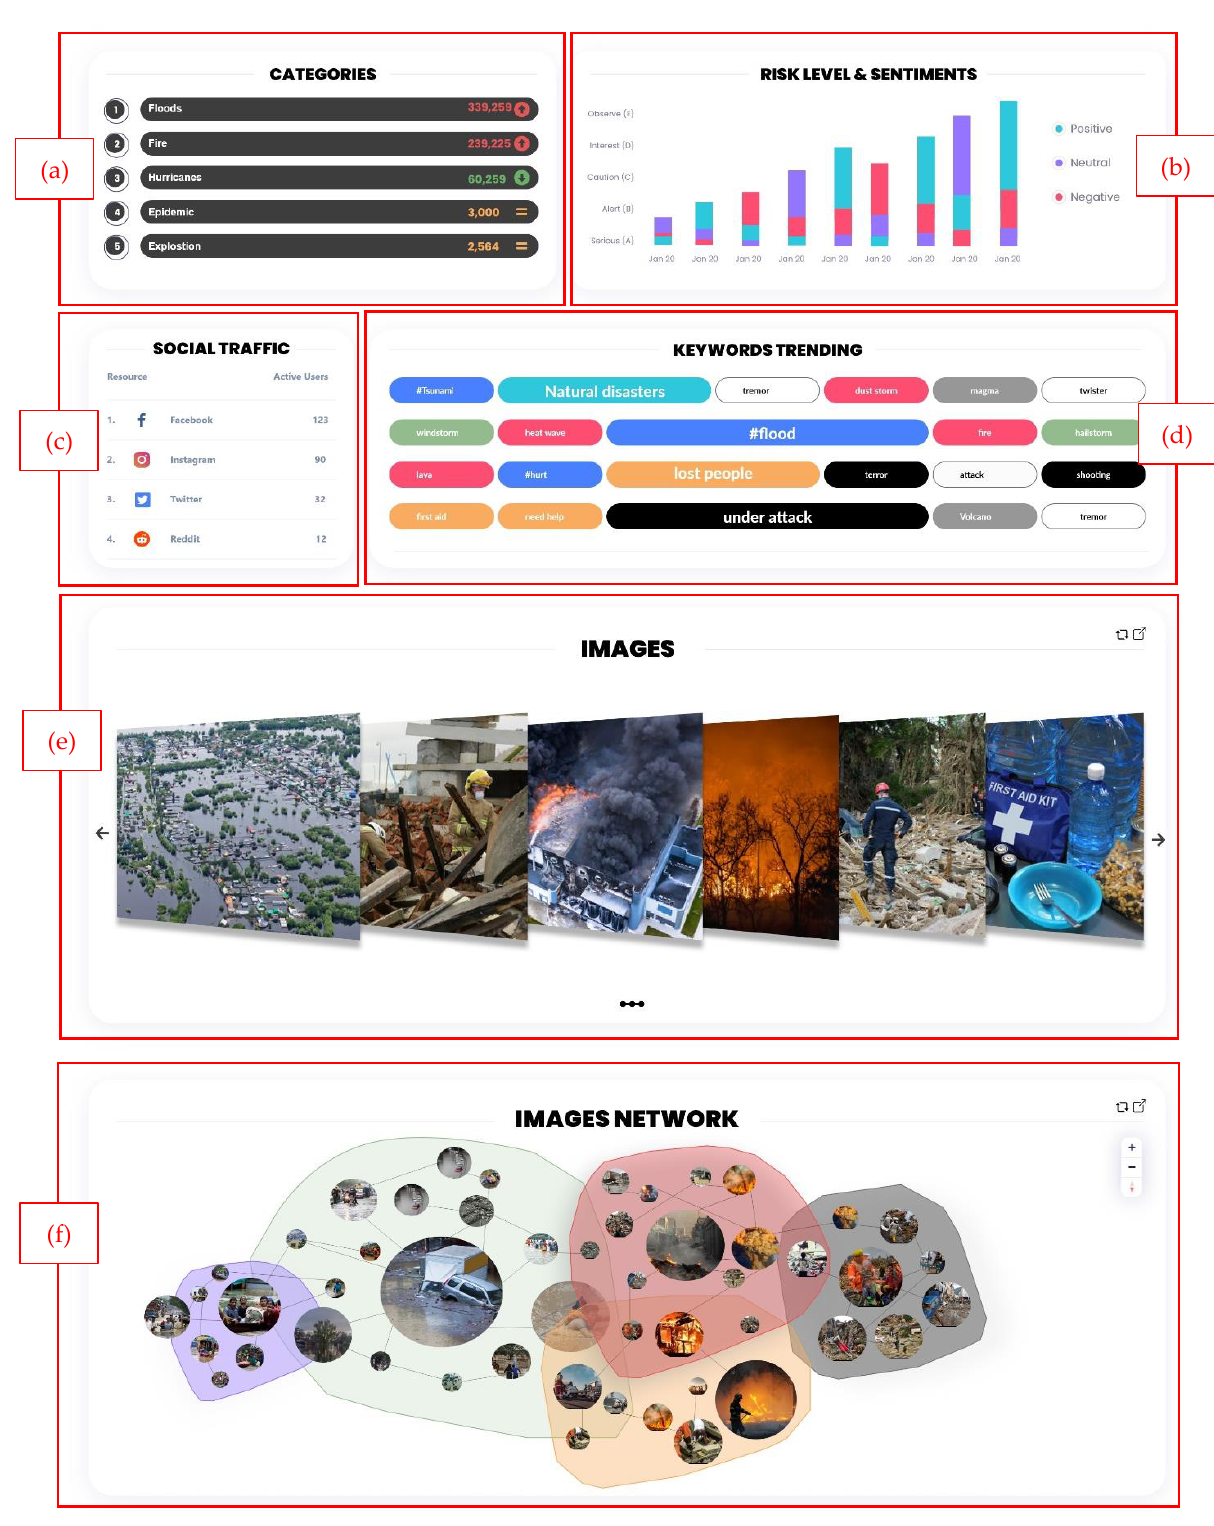
Figure 7. Multi-monitor visual analytics elements. ( a ) Crisis categories ranking, ( b ) risk and senti- mentally levels bar chart, ( c ) social traffic ranking, ( d ) keywords word cloud, ( e ) image gallery, and ( f ) image network.